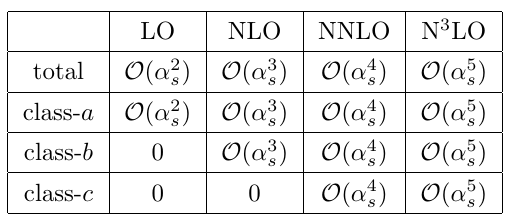
Table 1 . The perturbative orders in (cid:11) s for di(cid:11)erent classes at the amplitude squared level.